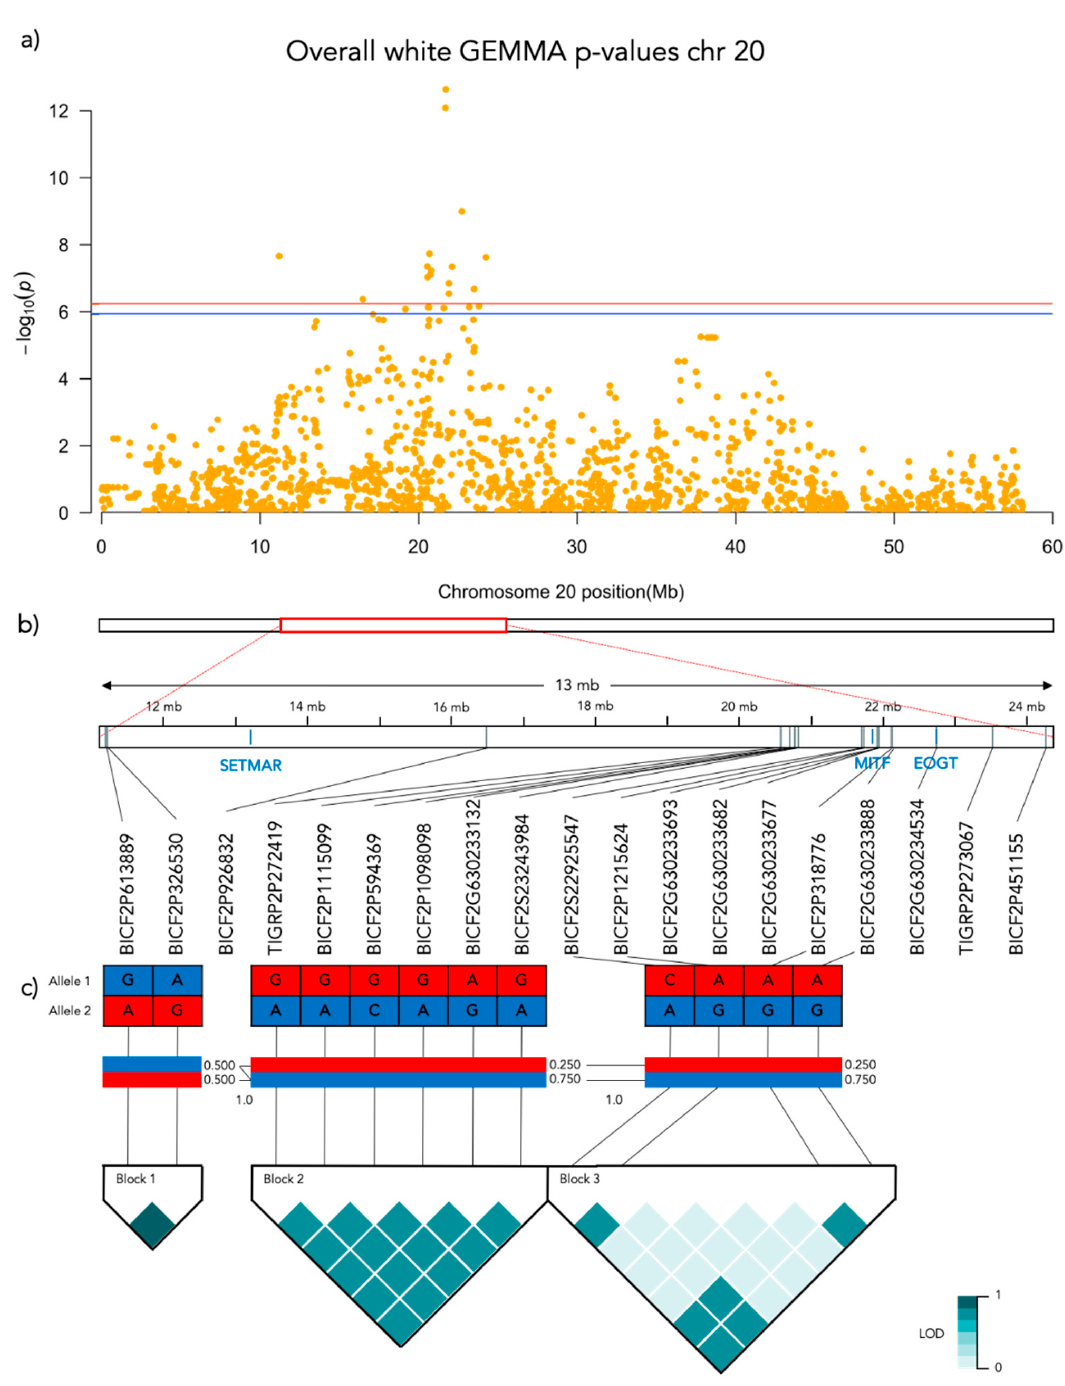
Figure 7. Results from the Genome-Wide Association analysis on the overall white phenotype for chromosome 20. ( a ) Manhattan plot of the chromosomes with significantly associated markers. The red line represents genome-wide significance of Bonferroni 5% and the blue 10%. ( b ) (upper) A schematic figure of the size and positioning of the significant region on the chromosome. (lower) Zoomed figure of the associated region showing the positioning of the significant SNP markers (grey) and genes (blue). ( c ) Linkage disequilibrium heat map and haplotype blocks of the significant markers.